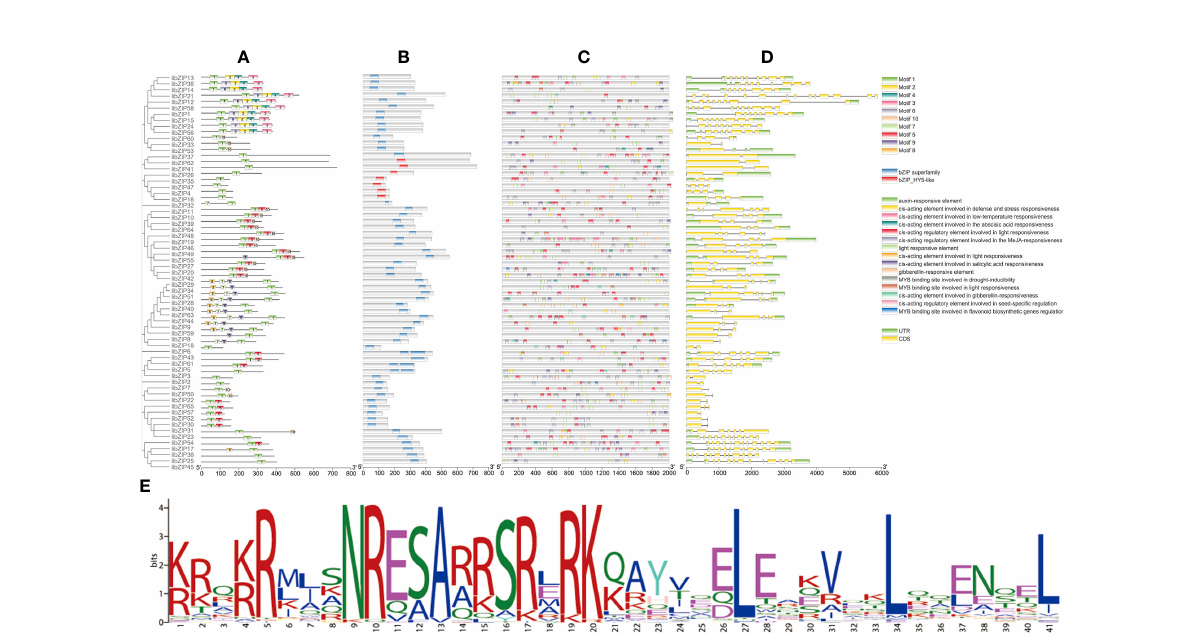
FIGURE 3 Gene structure and cis -element prediction of IibZIP proteins. (A) Motif analysis of IibZIP proteins. Different numbers represent different motifs. (B) Conserved domain and location information for each IibZIP gene. (C) Cis -elements in the promoter region of IibZIP genes. Different colored rectangles represent different cis -element components. (D) Structure of IibZIP genes. A green rectangle indicates an untranslated region; a yellow rectangle indicates the coding sequence region; lines indicate introns. (E) Amino acid sequence information for motif 1. The x-axis of (A, B) is the number of amino acids. The X-axis of (B, D) is the number of